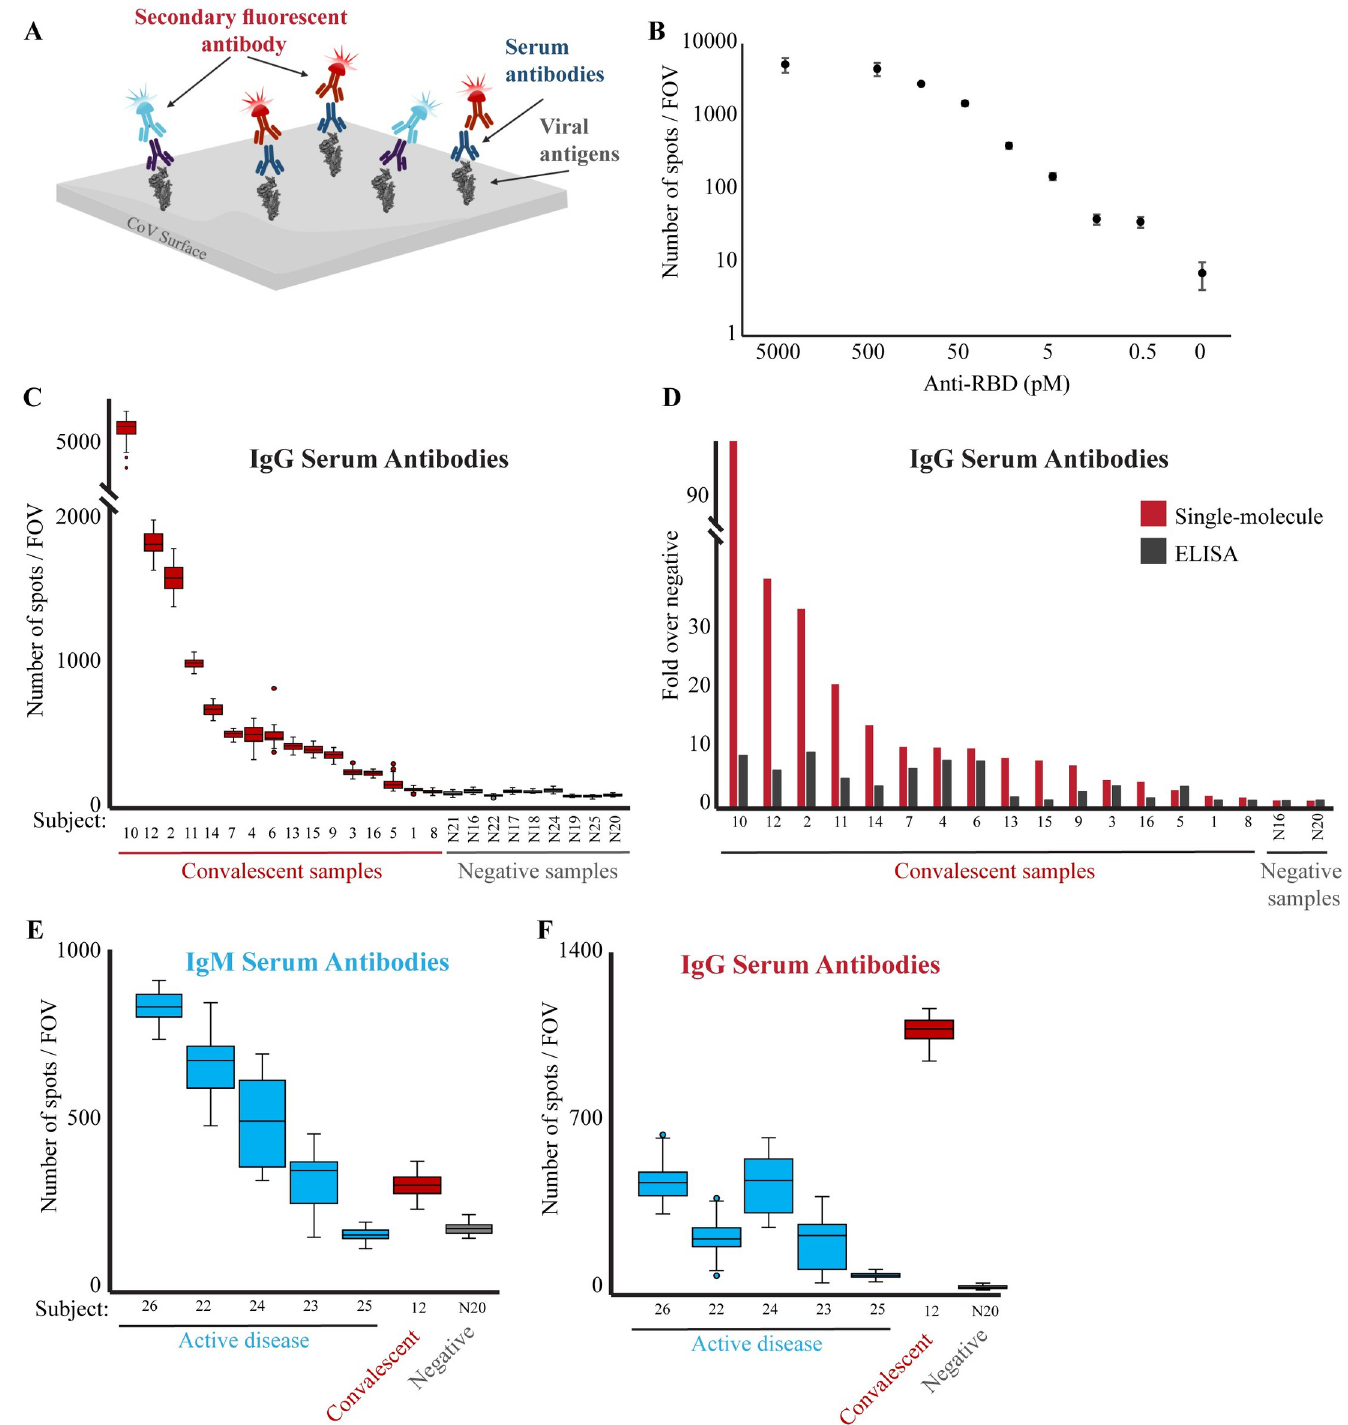
Fig 2. Single-molecule detection of anti-RBD antibodies. (A) Scheme of the serological diagnostic test. Serum samples are incubated with biotin-conjugated viral antigen (RBD) and loaded on a PEG-coated, streptavidin activated coverslip. Multiplex of fluorescently-labeled anti-human IgG (red) and IgM (light blue) antibodies are added to the flow cell and imaged. (B) Human anti-RBD antibodies at the indicated concentrations were incubated with biotin-RBD, and detected by fluorescently-labeled anti-human IgG antibodies. The Antibodies LoD is at picomolar concentrations. Both axes are in logarithmic scale, and the no anti-RBD antibody data point is not to scale. (C) Serum samples from either convalescent or not-infected subjects were diluted 1:2500 and analyzed as described in B to detect the presence of anti-RBD IgG antibodies in the subjects’ serum. The box plot shows the number of spots per FOV for all the FOV imaged for each sample in this